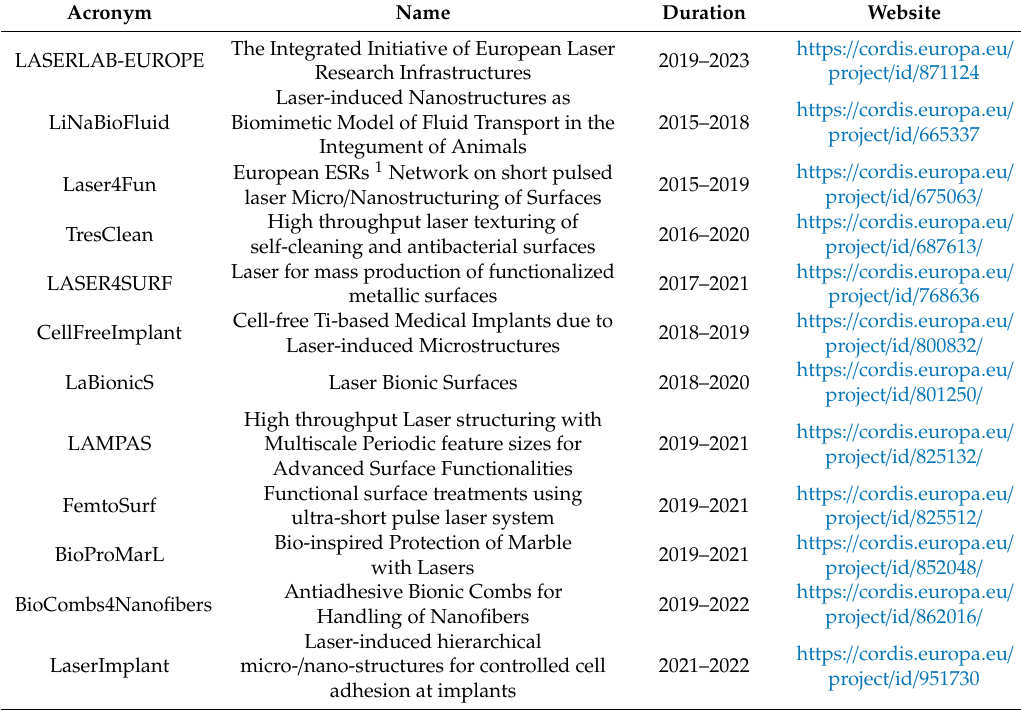
Table 6. Research projects on LIPSS funded by the European Commission (EC) within the Horizon 2020 (H2020)